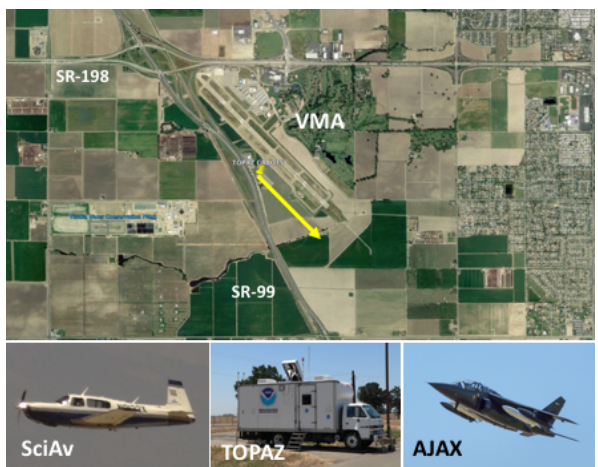
Figure 2. Aerial view of the Visalia Municipal Airport (VMA) showing the 1km lidar slant path line of sight as a yellow arrow with the TOPAZ truck located at the base. The Scientific Avia- tion Mooney and AJAX Alpha Jet are shown flanking the NOAA ESRL TOPAZ truck below the Google Earth image. Mooney and TOPAZ photos by Andrew O. Langford. Alpha Jet photo by Wil- fred von